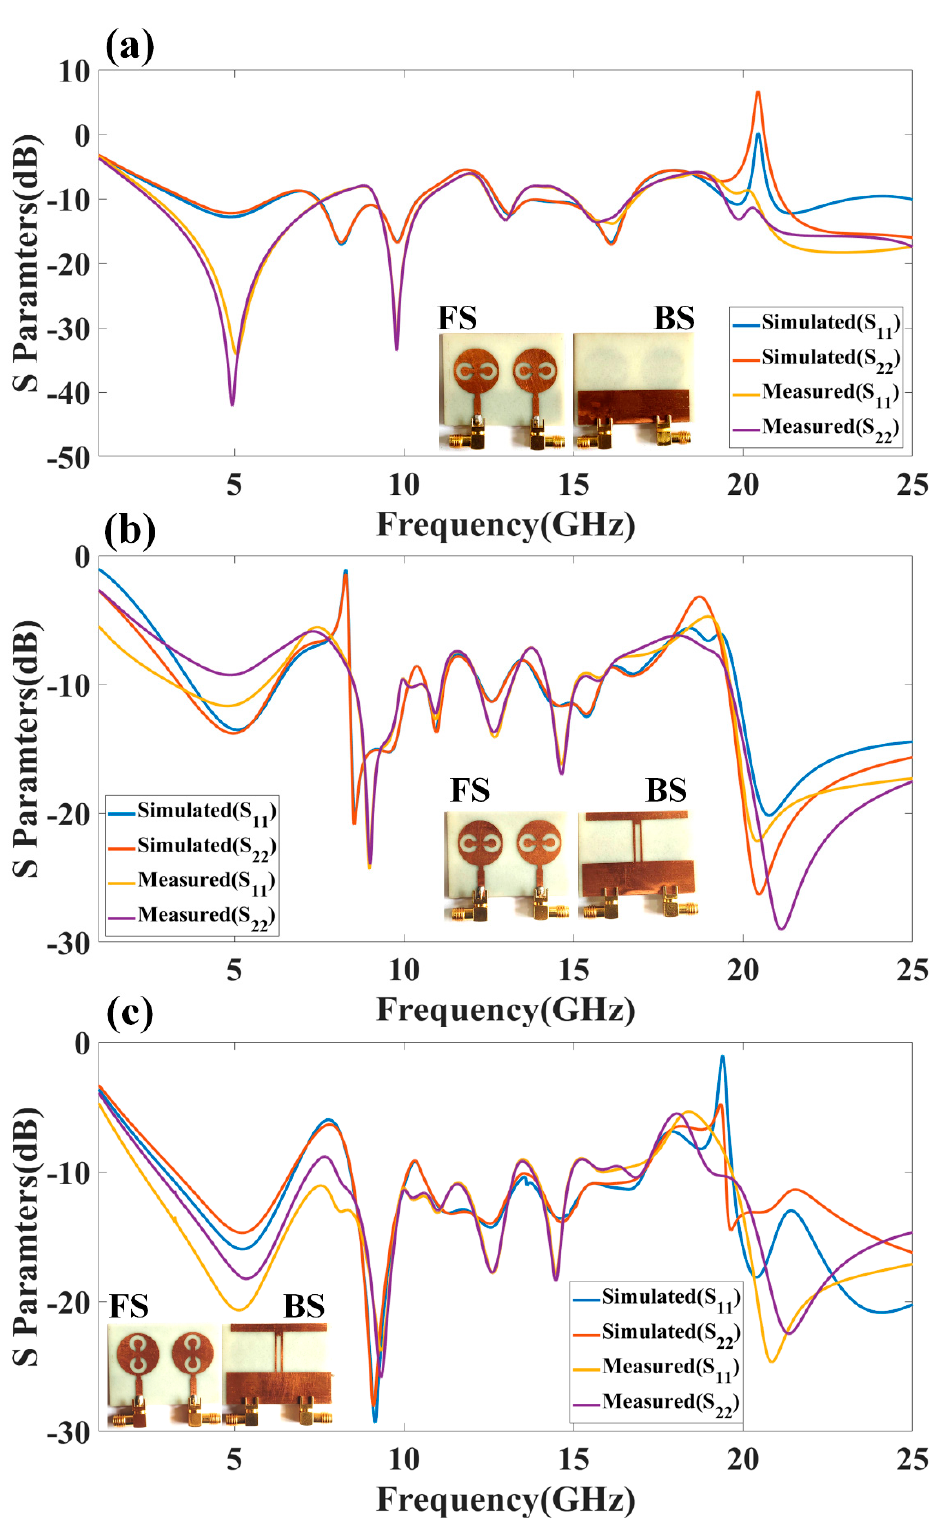
Figure 11. Comparative plot of simulation and measured reflectance loss factors (S 11 , S 22 ) (in dB) for ( a ) design 3, ( b ) design 4, and ( c ) design 5 of the proposed structure of the antenna.